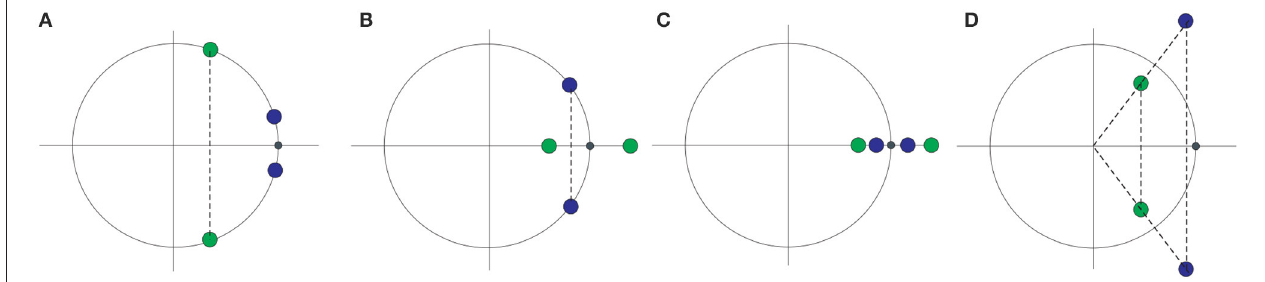
FIGURE 2 | Schematic plot of the initial configuration of the system (planetary case, m 1 , m 2 ≪ 1) and its final form (three stars with masses of the same order) obtained after µ -continuation.